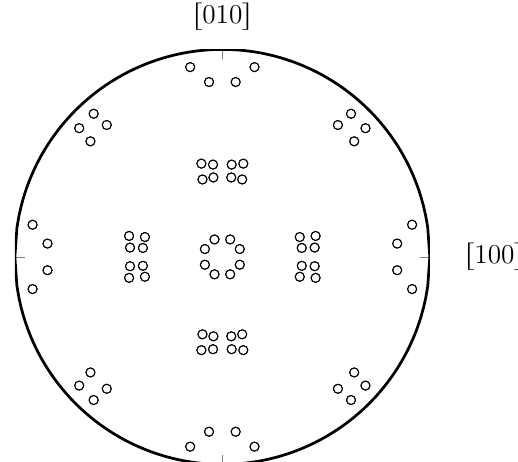
Figure 1. Pole projection of the normals of the {100} family of planes according to Kurdjumov–Sachs (KS) orientation relationships